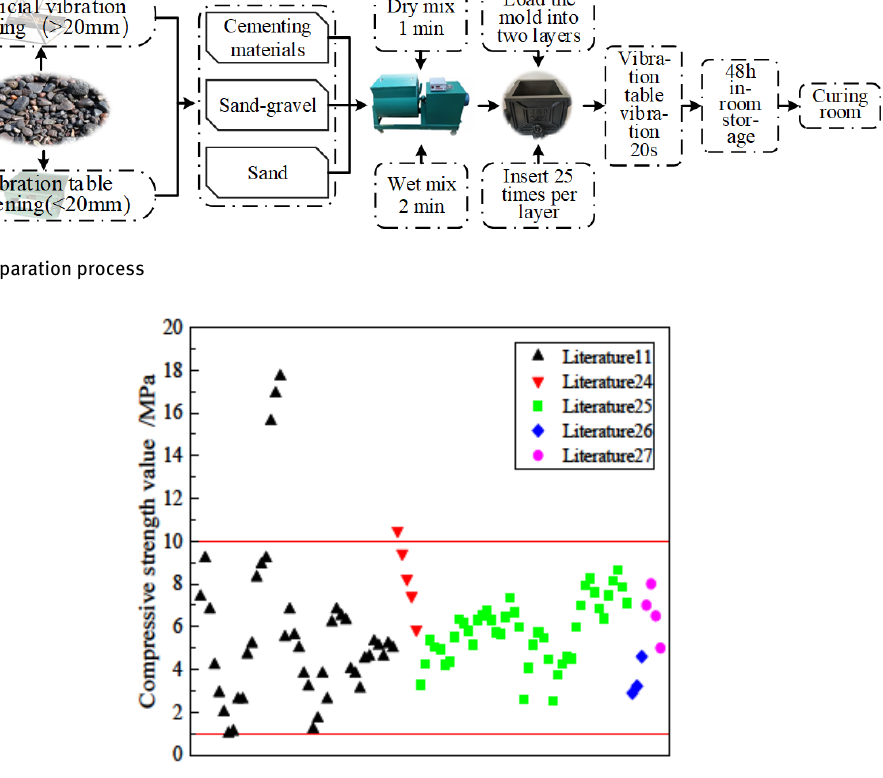
Figure 2: Data set of CSG 28d compressive